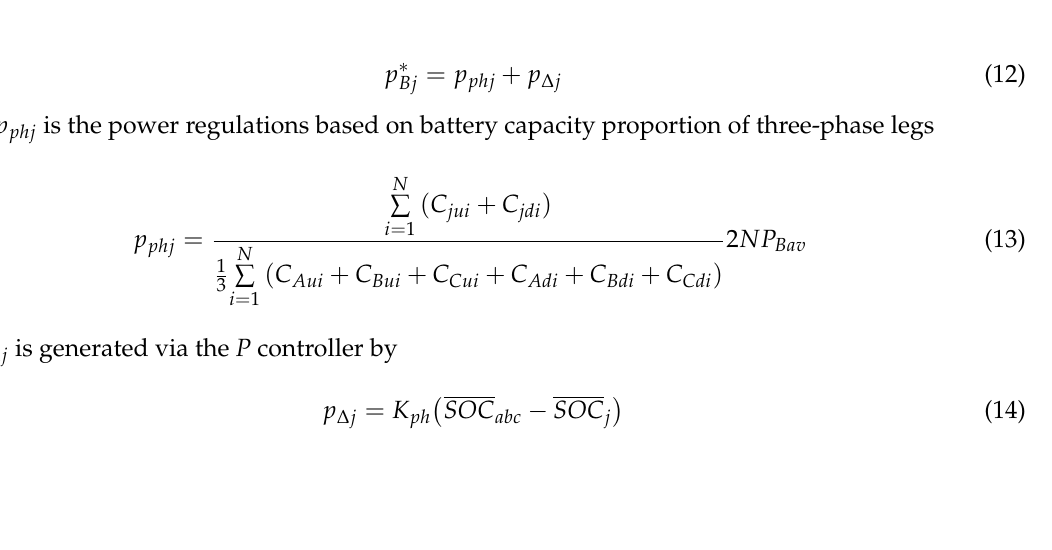
Figure 3. The phase-leg SOC balancing